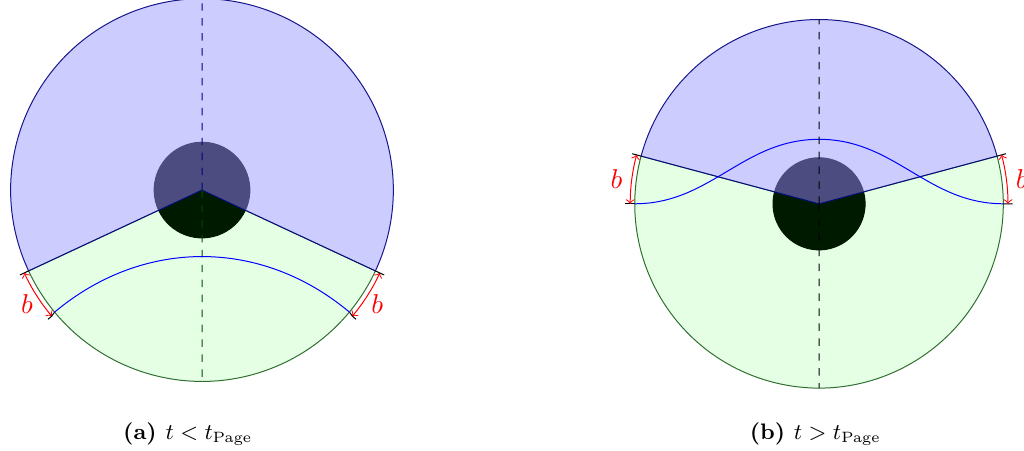
Figure 3. To find the entropy of the double interval [0 , b ] , including the quantum mechanical degrees of freedom, we need to compute the length of the blue